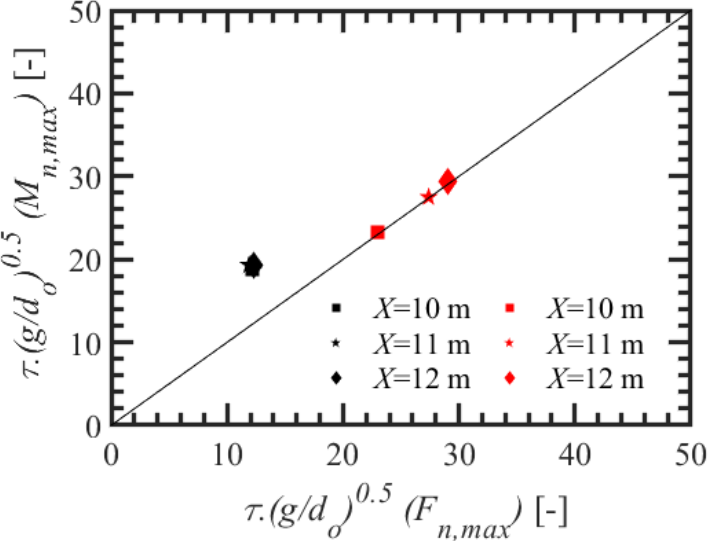
Figure 8. Comparison of time of maximum force and time of maximum moment. (Black represents d o = 0.9 m, and red represents d o = 0.6 m). τ = ( t − t n, im ), where t n,im refers to the time of interaction of surge with the structure.